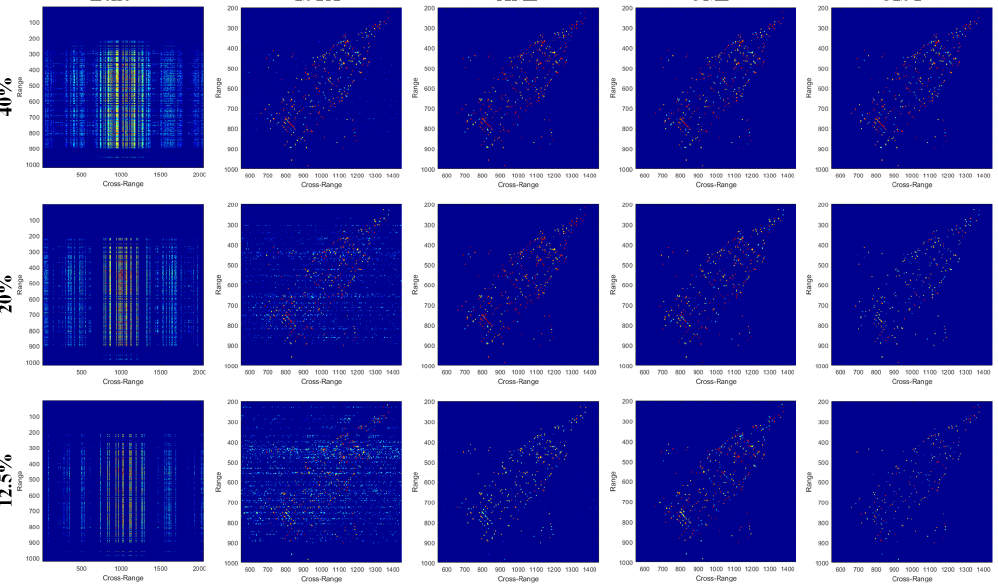
Figure 5. ISAR imaging results (SNR = 20 dB) of different methods at ratio 40%, 20%, and 12.5%,